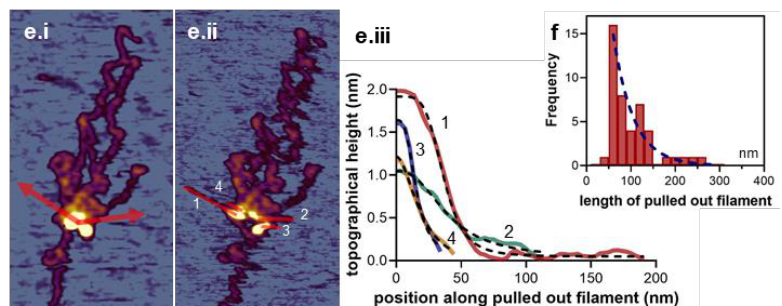
Figure 4. Nanosurgical manipulation of the titin M-complex. ( a ). AFM image of two titin oligomers prior to nanosurgical manipulation. Arrows indicate the site, direction, and distance of manipulation at the indicated speeds (10 and 1000 nm/s). ( b ). AFM image recorded after the nanosurgical manipulation. ( Insets ) show enlarged views of the two M-complexes. ( c ). Schematics explaining the effects of nanosurgical manipulation of the M-complex at different manipulation speeds. ( d.i ). Control AFM image of three titin oligomers containing M-complexes of different size prior to nanosurgical manipulation. Arrows indicate the site, direction, and distance of manipulation. ( d.ii ). AFM image recorded after the nanosurgical manipulation. ( Insets 1 – 3 ) show the magnified images of each modified structure. Arrows point at regions of material accumulation, possibly due to debris deposition. ( e.i ). AFM image of a titin oligomer stretched with meniscus force prior to nanosurgical manipulation. Arrows indicate the site, direction and distance of manipulation. ( e.ii ). AFM image recorded after the nanosurgical manipulation. Numbers indicate the filaments pulled out of the M-complex, which were further analyzed for axial height distribution. ( e.iii ). Topographical height of the pulled-out filament as a function of distance from origin. Numbers correspond to the filaments marked in e.ii. Segmented lines are fits of equation 1 on the data. The r 2 values of the fits are >0.95 for each dataset. ( f ). Distribution of the length of filaments pulled out of the M-complex. The distribution was fitted with the exponential function f = e − cl , where f is statistical frequency, l is filament length, and c is a characteristic length scale. The r 2 value of the exponential fit is